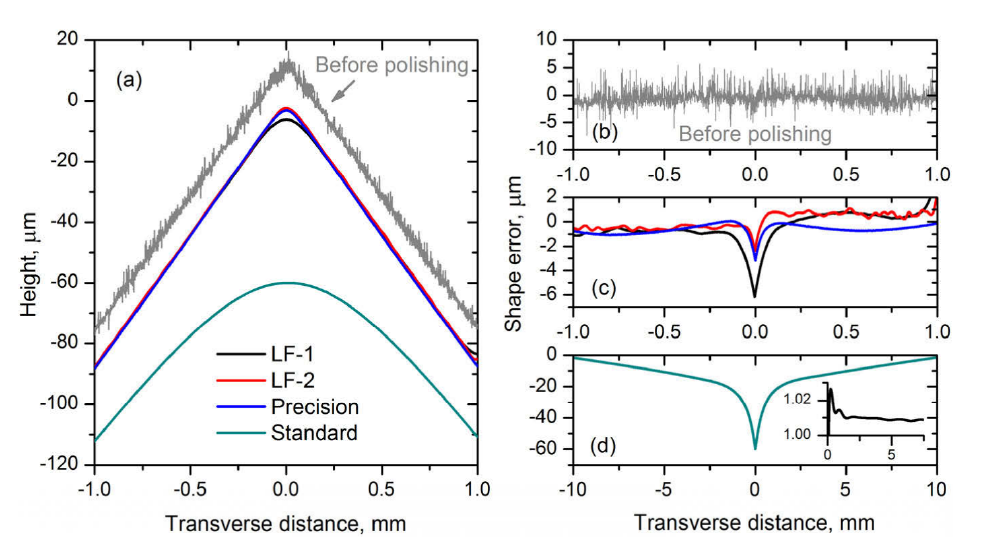
Figure 10. The precision of profile of the ultrafast laser-made axicon with subsequent CO 2 polishing and comparison to commercial high-precision and standard counterparts. The un-polished and polished laser-made profiles are offset to better reveal the difference between them. Reproduced from